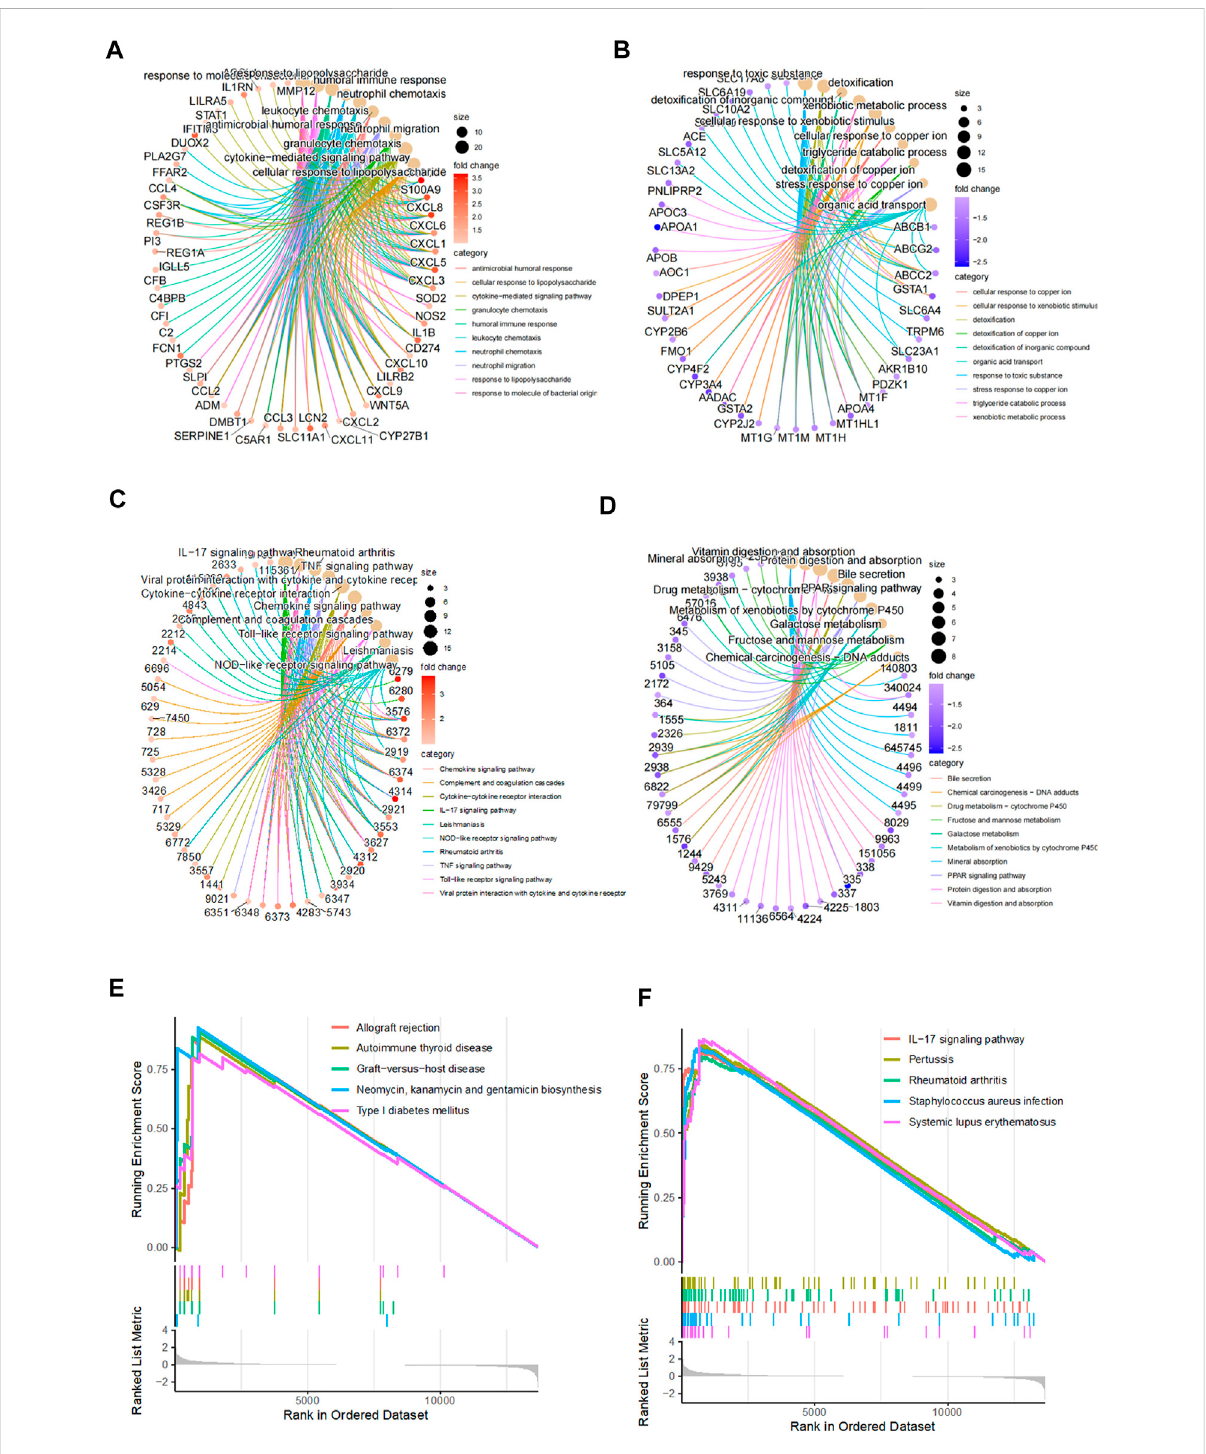
FIGURE 2 Functionalenrichmentanalysisfordifferentiallyexpressedgenes. (A – B) Top10upregulatedanddownregulatedGOtermsinCDdisease. (C – D) Top10upregulatedanddownregulatedKEGGpathwaysinCDdisease. (E – F) Top10upregulatedKEGGpathwaysgeneratedbygenesetenrichment